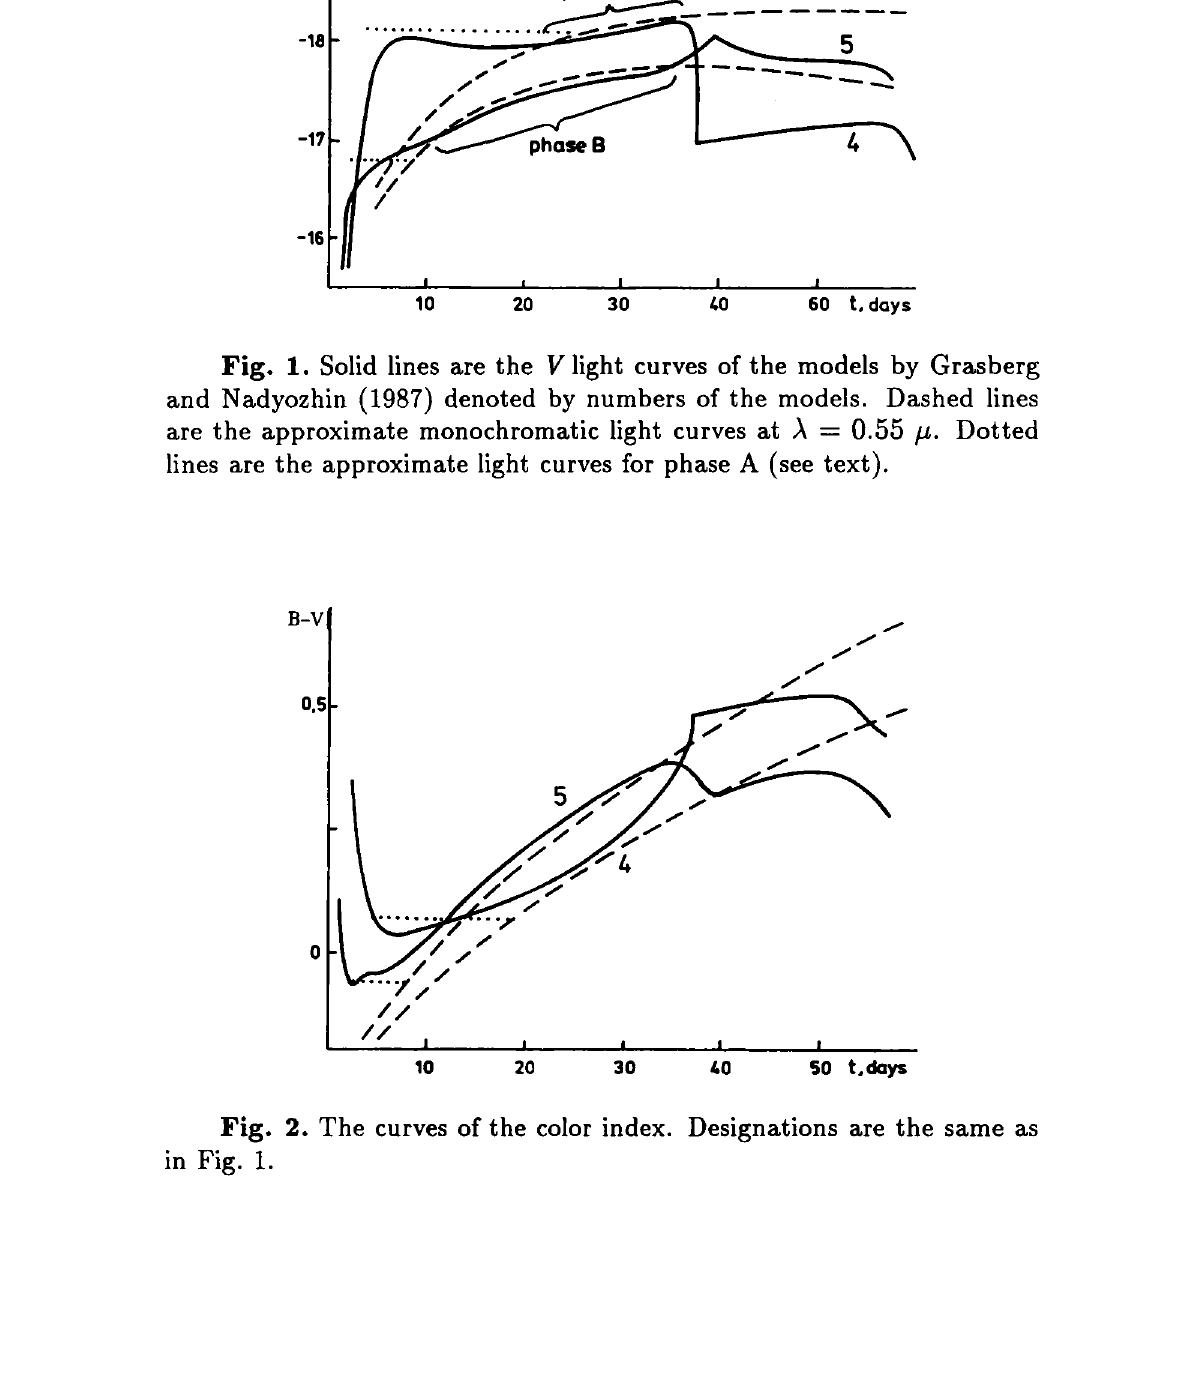
Fig. 2. The curves of the color index. Designations are the same as in Fig.